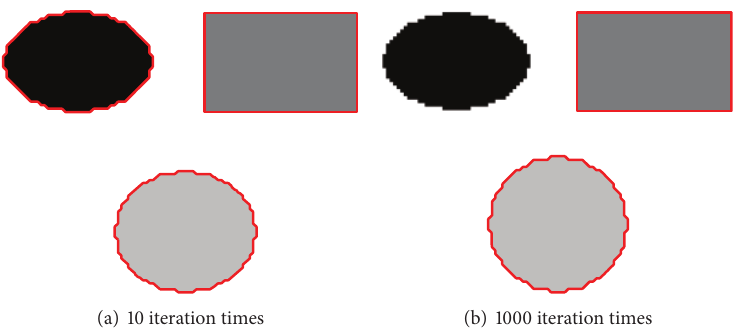
Figure 2: Multitarget image segmentation with target controllable